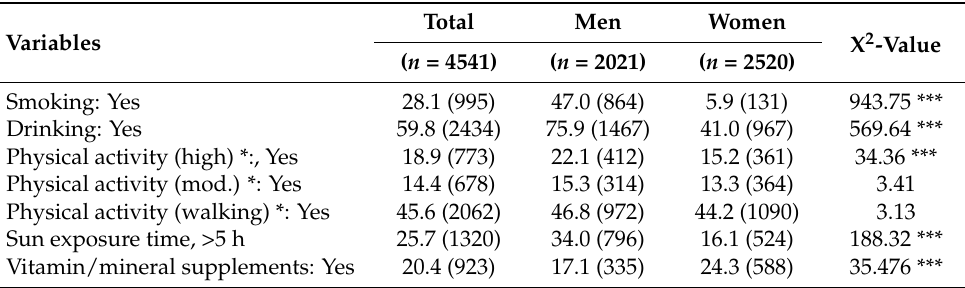
Table 1. Characteristics of